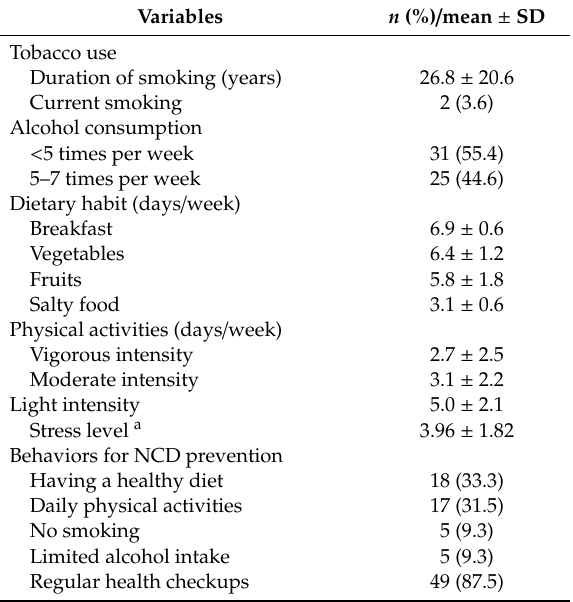
Table 2. Lifestyle and behaviors for non-communicable disease (NCD) prevention in Japanese older adults.